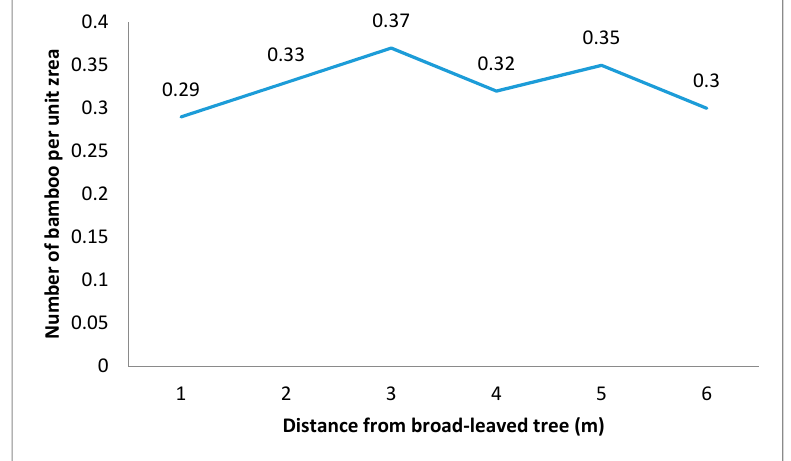
Figure 3. Number of bamboo per unit area at different distances.